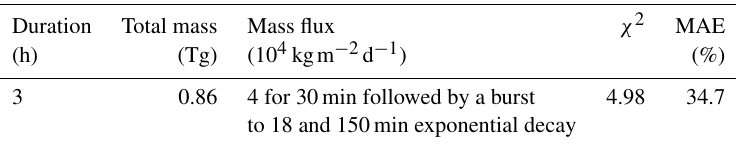
Figure 12. Static stability (gradient of potential temperature in ◦ Kkm − 1 ) versus time at the same two points than in Fig. 11 (lake in blue and valley in red) according to WRF simulations at 1km resolution. The potential temperature gradient has been computed using WRF σ levels 1 and 6, at roughly 12 and 100m above terrain, respectively. Positive values indicate stable atmosphere. Note the transition from unstable to stable stratification occurring after 16:00UTC. Table 4. Source term characteristics of the best-fit simulation showing total CO 2 emitted mass, mass flux variation, χ 2 , and mean absolute error (MAE) considering the five-class binning